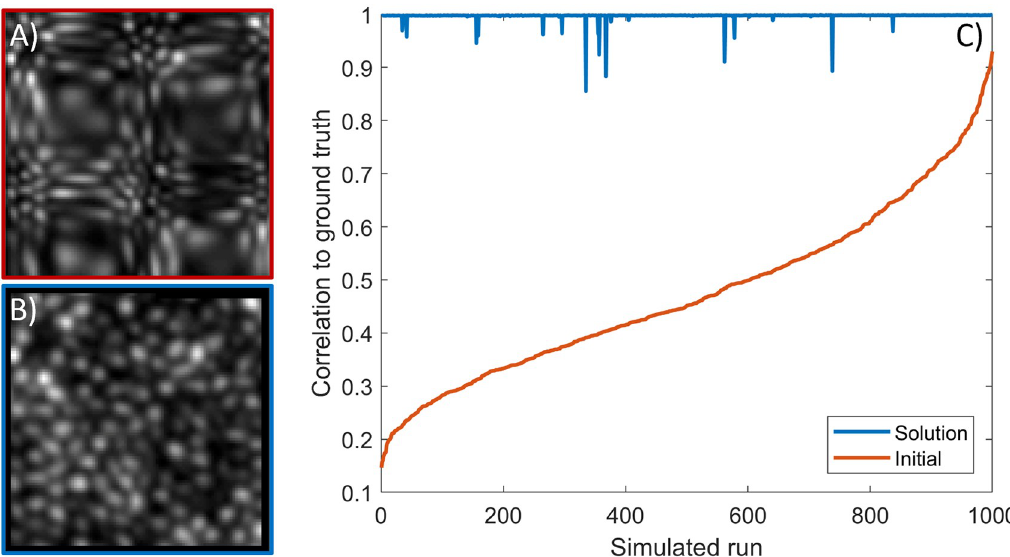
Fig 6. Outcomes from 1000 different static distortion maps. On each run a random 2D distorting function was generated, and sampled at 4 randomly selected gaze positions (see text for details). A) Shows the worst simulated image, i.e. the one least correlated with the ground truth. B) Shows the recovered image for A. C) Plots the baseline (red) and recovered (blue) correlation with the ground truth for all 1000 runs. Only 17/1000 recovered images failed to reach a correlation above 0.99.